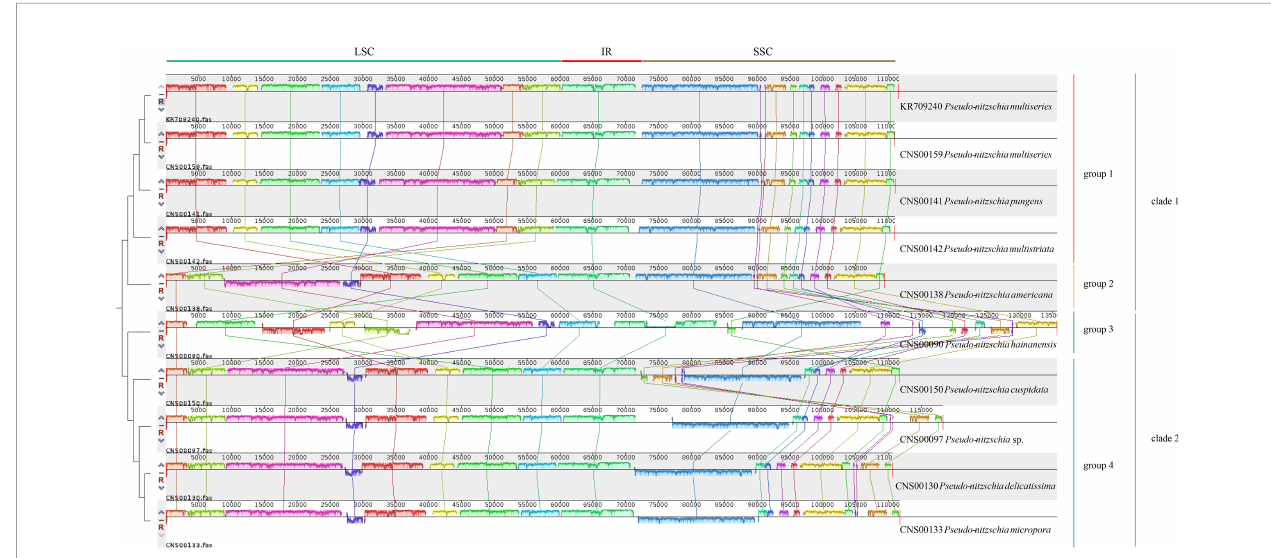
FIGURE 4 | Synteny comparison of 10 Pseudo-nitzschia cpDNAs using Mauve. Rectangular blocks of the same color indicate collinear regions of sequences. Vertical bars inside collinear blocks show degree of sequence identity. The color blocks at the top indicate different collinear regions located roughly in LSC, IR or